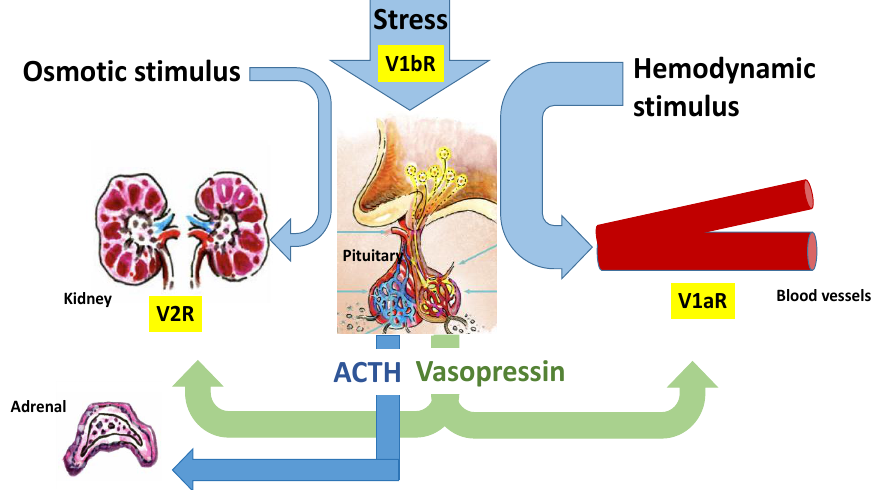
Figure 2. Regulation of arginine vasopressin (AVP) and Copeptin release. AVP is released with copeptin from the posterior pituitary into the systemic circulation in response to hemodynamic and osmotic stimuli, in order to preserve vascular tone (V1a-R) and fluid homeostasis (V2-R). A second neurosecretory pathway delivers AVP from parvocellular neurons through the portal vessels to the anterior pituitary, where it acts synergistically with corticotropin-releasing hormone (CRH) to stimulate adrenocorticotropic hormone (ACTH) and, thus, cortisol synthesis in response to stressors (V1b-R). Moreover, AVP binding to the V1b-R located in the adrenal medulla results in short-term catecholamine secretion.